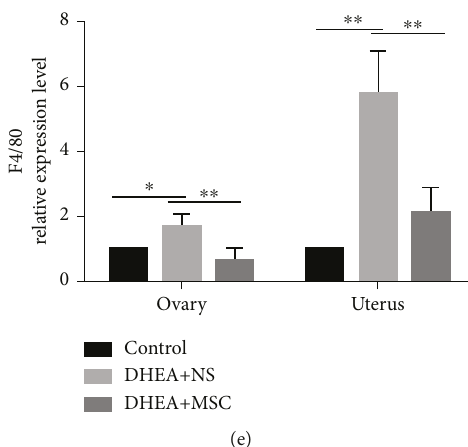
Figure 4: hUC-MSC treatment a ff ects innate immunity cell compartments in PCOS mice. Flow cytometry results of innate immunity cells in the peripheral blood and spleen. (a) The percentage of peripheral and splenic neutrophils (Ly6G + CD11b + ). (b) The percentage of peripheral and splenic macrophages (F4/80 + ). (c) The percentage of peripheral and splenic M1 macrophages (CD11c + ). (d) The percentage of peripheral and splenic M2 macrophages (CD206 + ). (e) Quantitative RT-PCR analysis of the expression of F4/80 in the ovaries and uterus of mice. n = 8 -10 per group. Values are expressed as the means ± SEM . ∗ P < 0 05 and ∗∗ P < 0 01